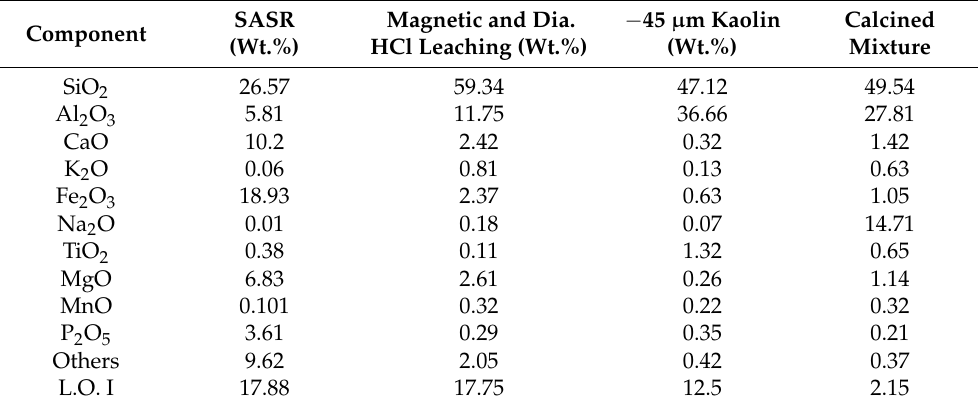
Table 1. Overall chemical composition of the sulfuric acid solid residue (SASR) before and after the pre-treatment processes. Component